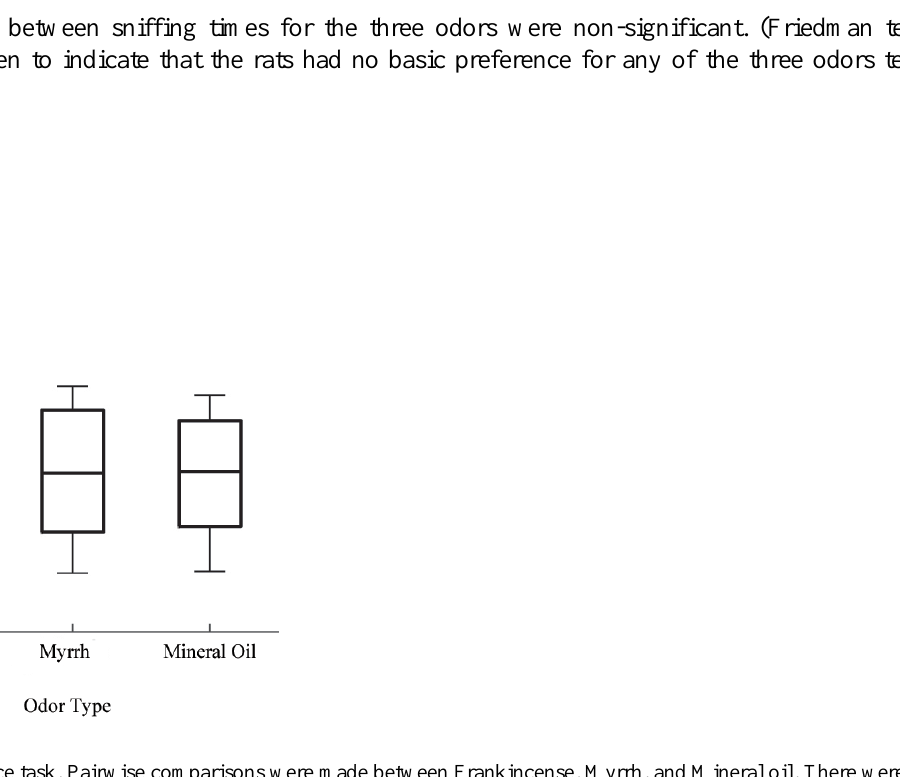
Figure 4 . Odor preference task. Pairwise comparisons were made between Frankincense, Myrrh, and Mineral oil. There were no significant differences between sniffing times of any of the three odors presented to the rats. Y-axis units are in seconds. Center line = median. Top = 75 th percentile, bottom = 25 th percentile. * p <